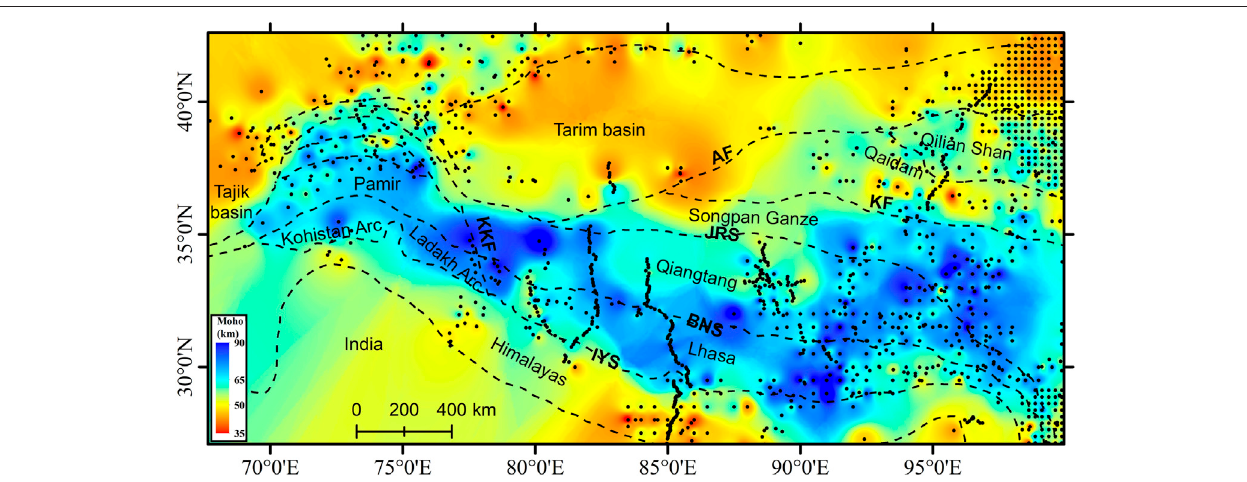
FIGURE 6 | Map of crustal thickness beneath the Pamir – Tibetan plateau. The Moho depth values have been obtained from receiver function analysis conducted acrossthePamir and Tibetanplateau.Theblack circles markthelocationsoftheseismicstations. AF, Altyn-TaghFault; KF, Kunlun Fault; JRS, JinshaRiver Suture;IYS, Indus Yarlung Suture; BNS, Bangong-Nujiang Suture; KKF, Karakorum Fault. The crustal thickness values beneath the Pamir plateau have been taken from published data of the TIPAGE (Schneider et al., 2019) and East Pamir seismic experiment (Xu et al., 2021). Beneath the Tibetan plateau, we have used the crustal thickness valuesderivedfromthereceiverfunctionsalongHi-CLIMB(LiJ.andSongX.,2021),NamcheBarwaProject(Xuetal.,2013),ANTILOPE-IandII(Xuetal.,2015;Xuetal., 2017; Murodov et al., 2018), TW-80 (Zhang et al., 2014), INDEPTH (Yue et al., 2012), (Tian and Zhang, 2013; He et al., 2014; Cheng et al., 2021).